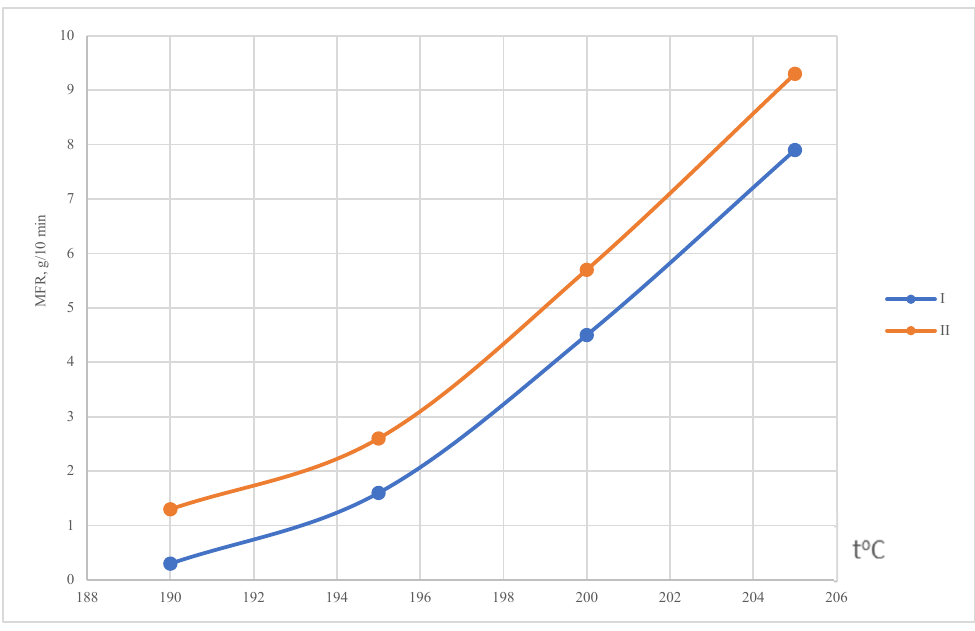
Figure 7. Dependence of the MFR of PVC composition on temperature. I, II—Symbols of plasticizers (Table 5).